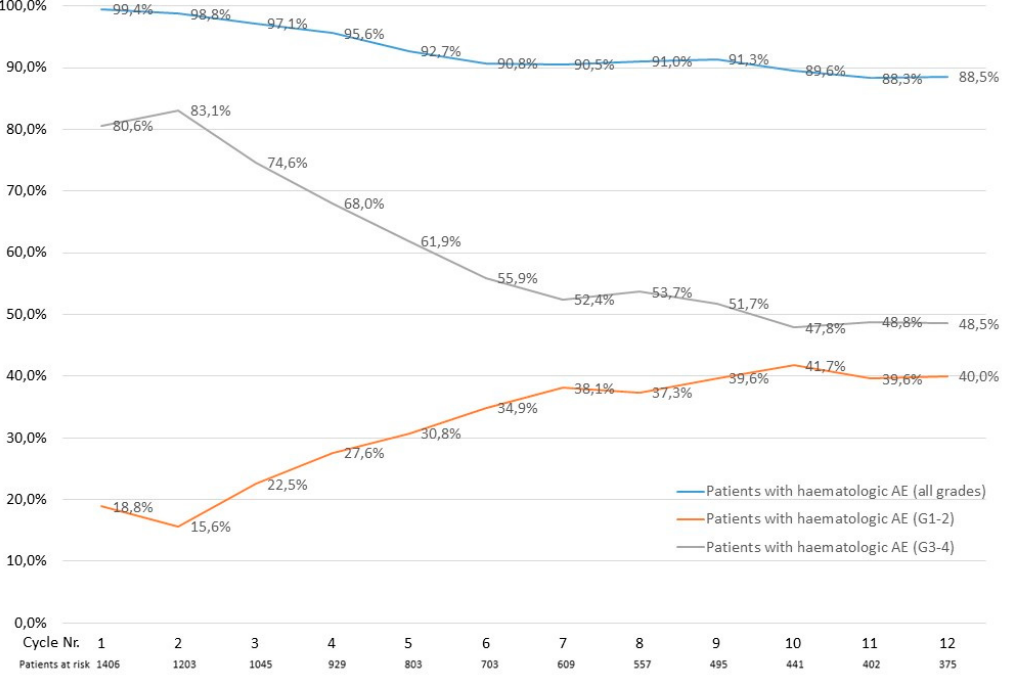
Figure 3. Percentage of patients who experienced a calculated hematologic AE per azacitidine treatment cycle.